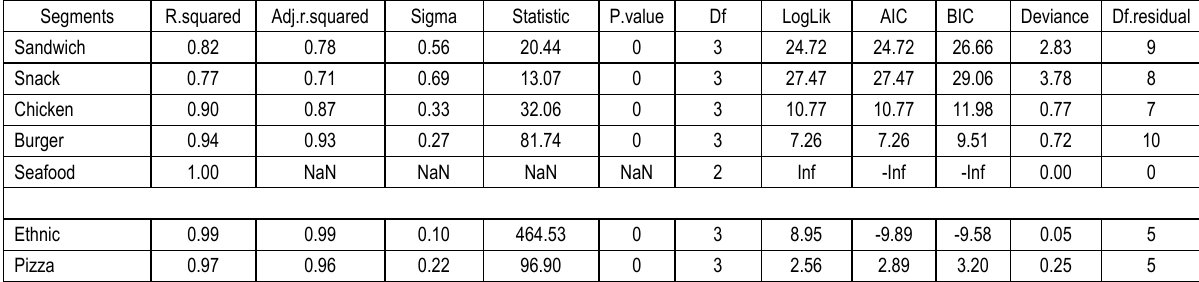
Table 16. Quality measures of regression